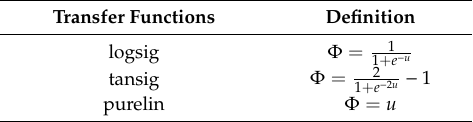
Table 4. Di ff erent transfer function